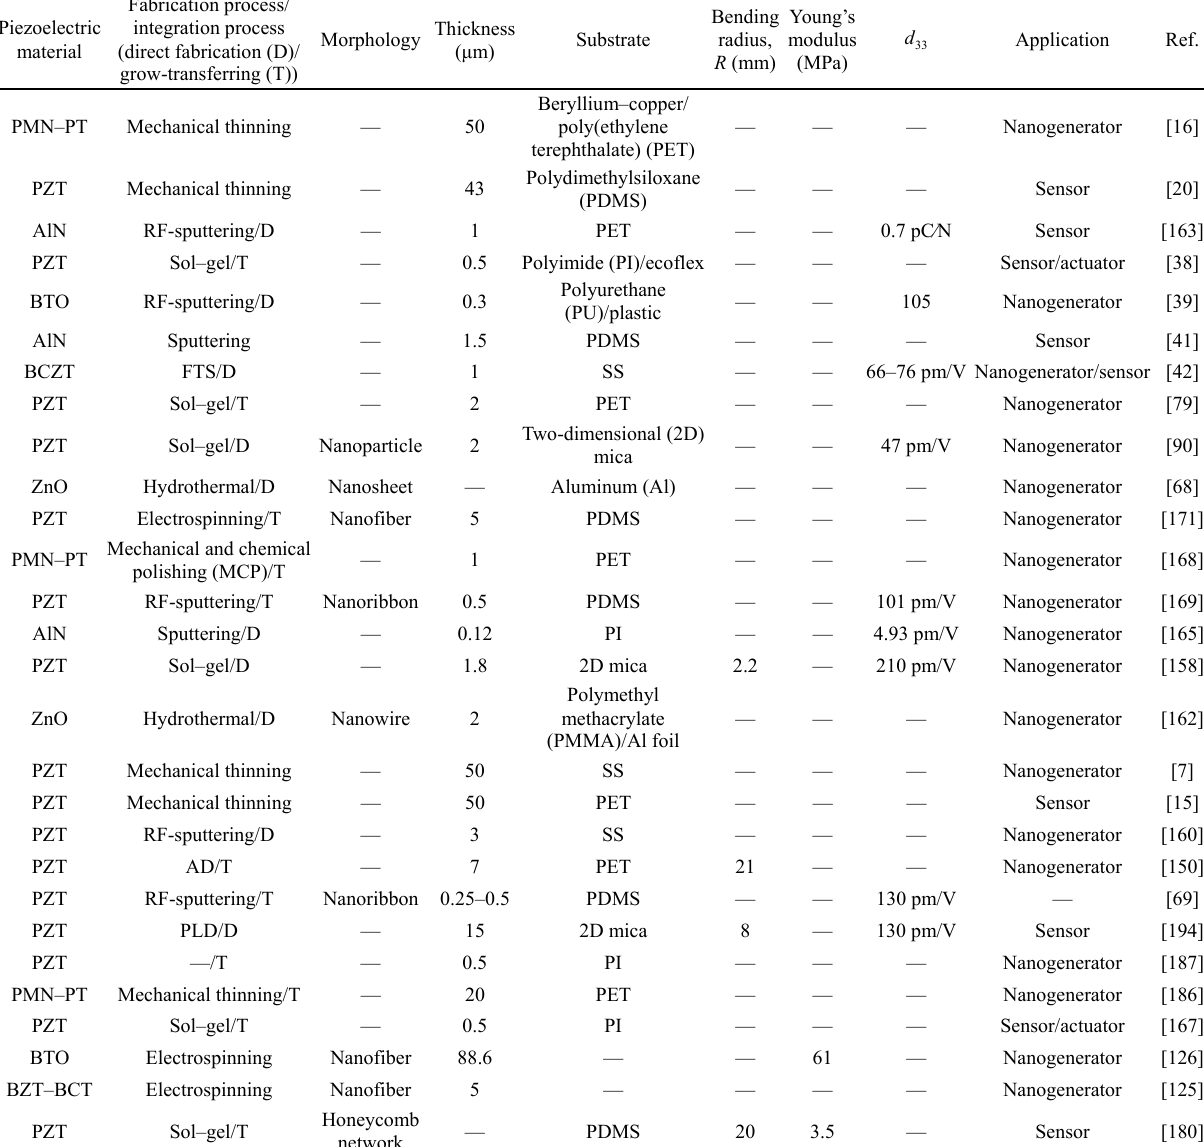
Table 1 Properties and applications of flexible inorganic piezoelectric thin films based on various fabrication methods Piezoelectric